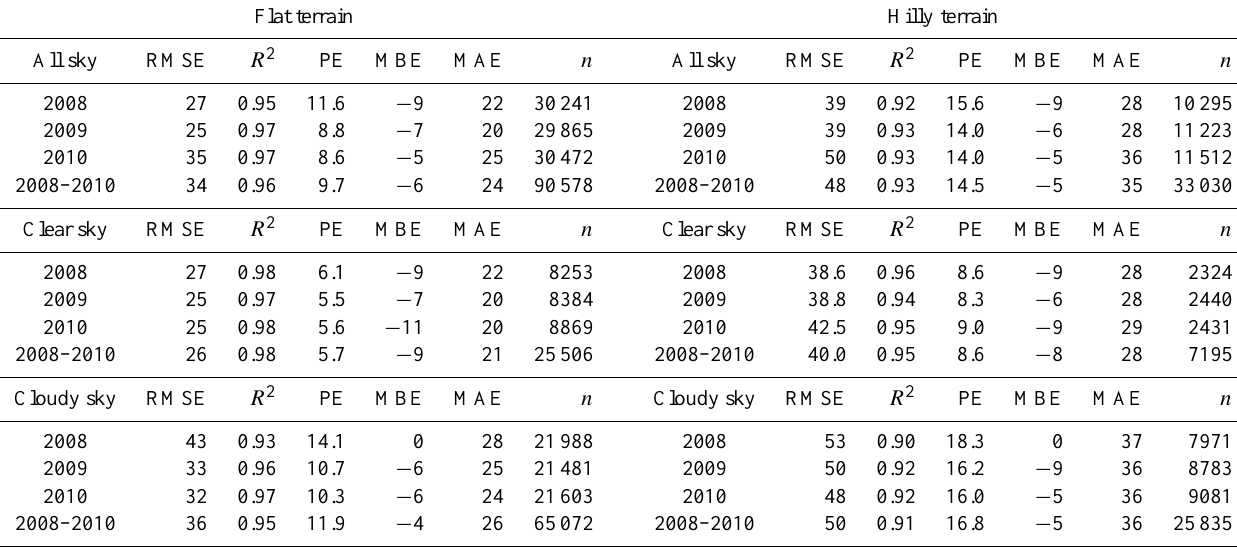
Table 4. Daily solar radiation error and accuracy statistics depending on flat or hilly terrain and clear sky or cloudy sky conditions from 2008 to 2010. RMSE, MBE and MAE in Wm − 2 , PE in percentage and n is the number of samples. Flat terrain Hilly terrain All sky RMSE R 2